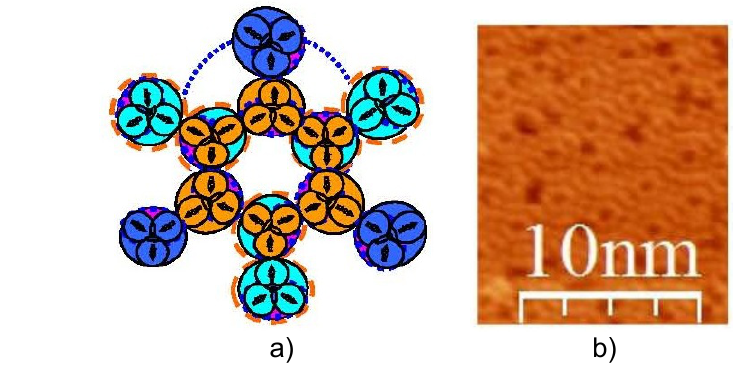
Figure 6 – Cluster of triatomic molecules: a) theoretical calculation; b) experimental